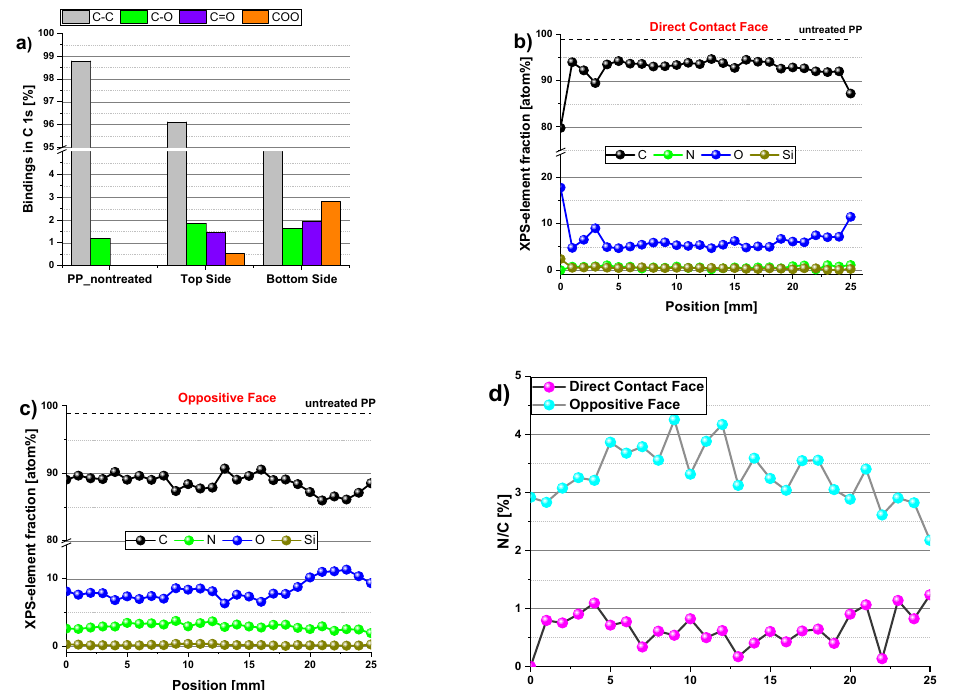
Figure 6. Distribution of the elemental composition of the plasma-treated PP samples; ( a ) Comparison of different carbon groups detected on the untreated PP and both sides of the plasma-treated sample; ( b ) on the DCF; ( c ) on the OF; ( d ) longitudinal distribution of the N/C ratio on both sample sides.